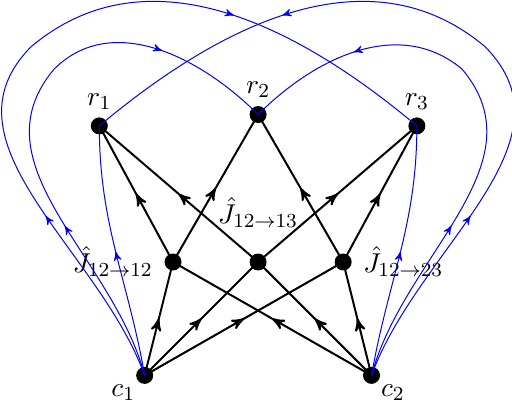
Figure 12. Schematic diagram of the boundary causal structure in 2-to-3 holographic scattering. The regions ^ J 12 ! jk are all nonempty, meaning it is possible for signals to travel from c 1 and c 2 meet, and then get to either of r j or r k . There are also causal curves that travel directly from c i to r j without passing through any of the regions ^ J 12 ! jk . This fact is crucial for the entanglement- free